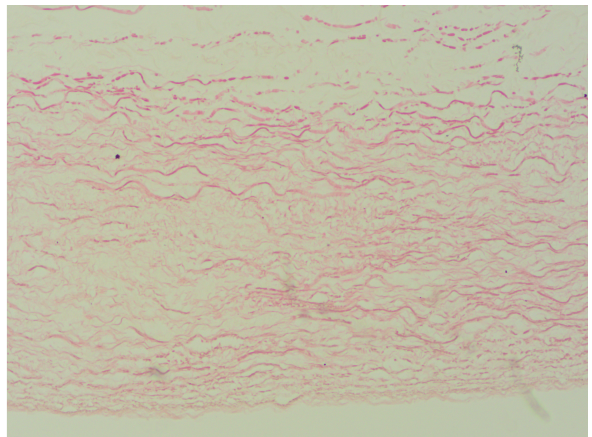
Fig. 1 - Amostra de pericárdio bovino corado com HE 200x pós- processo de descelularização. Observamos ausência de células, arquitetura das fibras da matriz extracelular